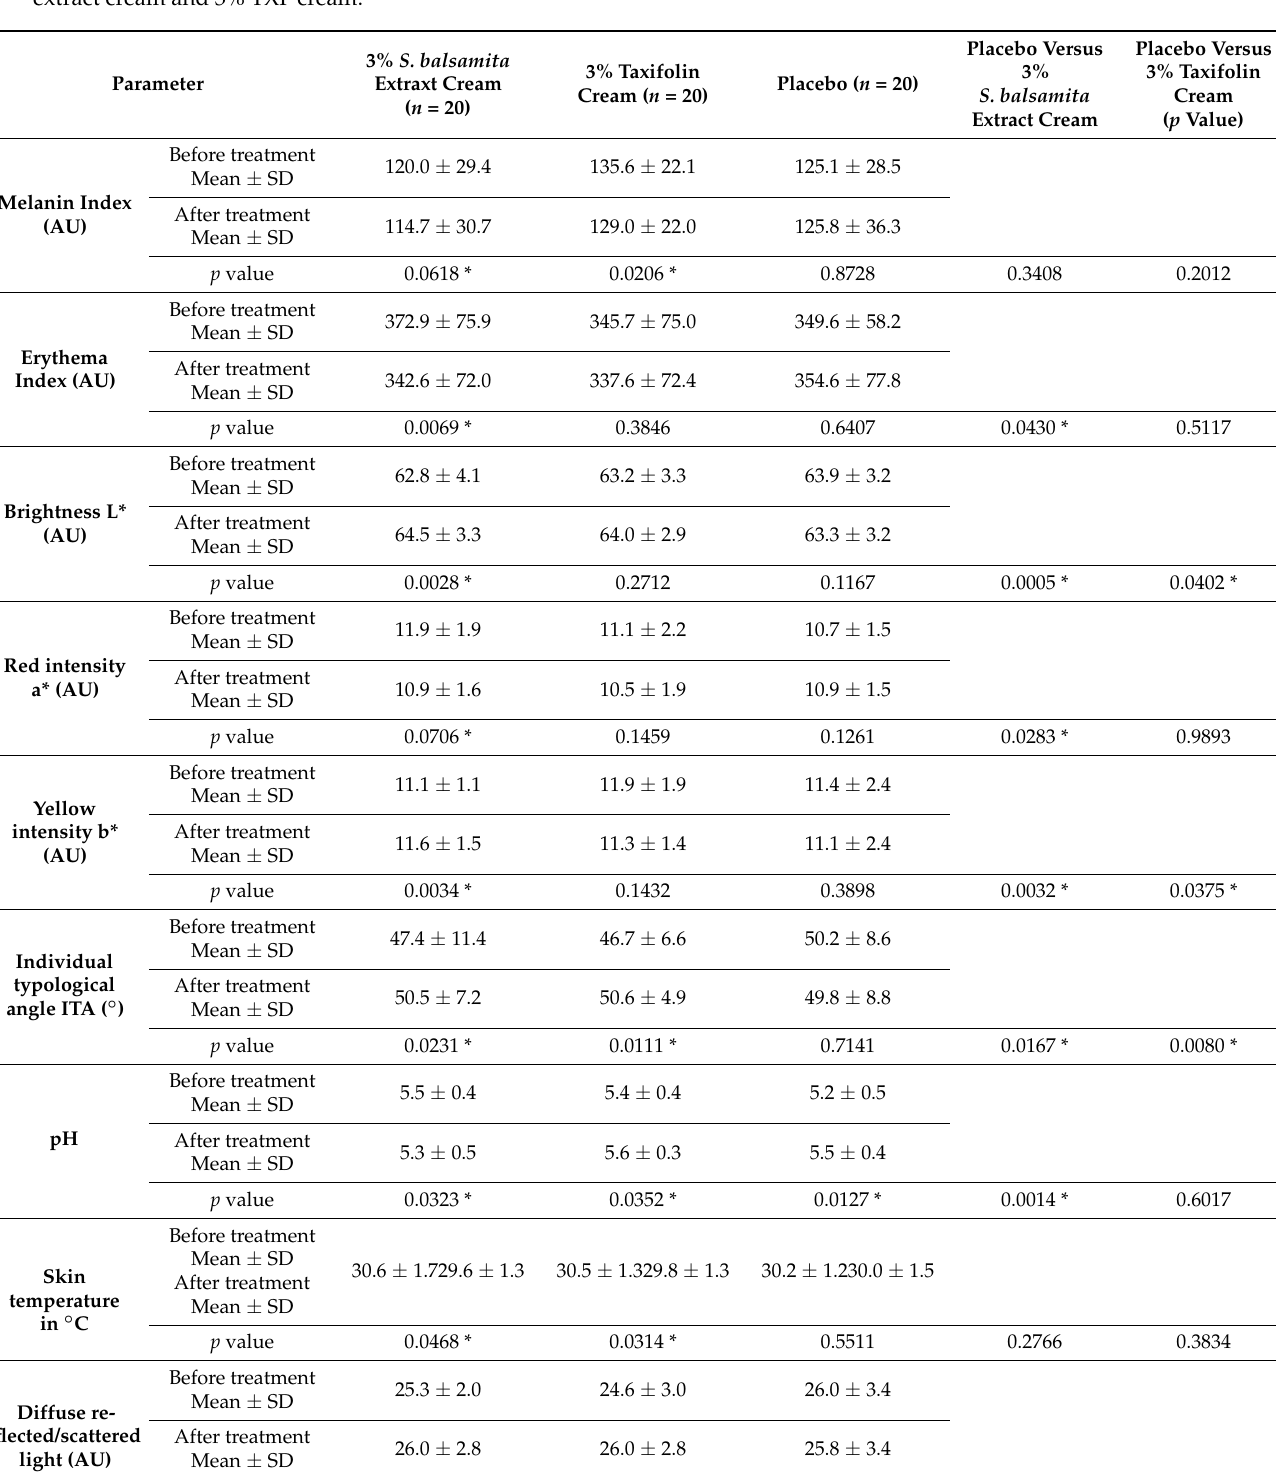
Table 4. Detailed results of skin biophysical parameters comparison before and after treatment with the 3% S. balsamita extract cream and 3% TXF